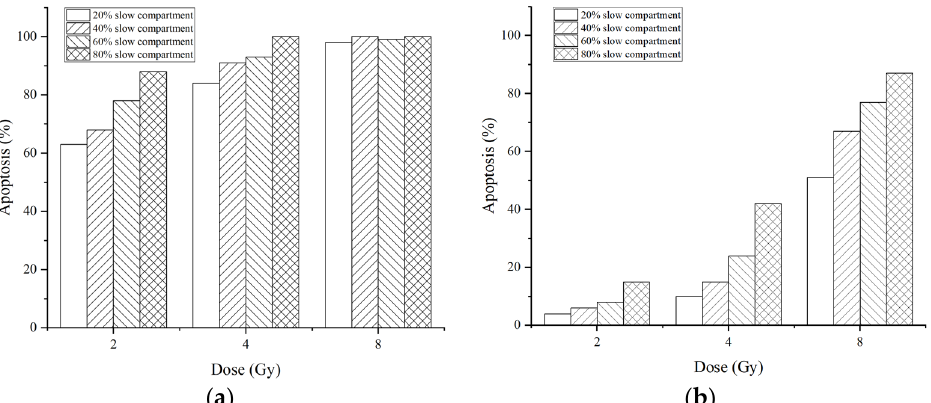
Figure 6. Percentages of apoptosis for cells with the half-saturation threshold of ATM equivalent to 0.14 Gy ( a ) and 0.5 Gy ( b ) at 72 h after 2.0–8.0 Gy irradiation. The cells are repaired by 20–80% slow compartments.